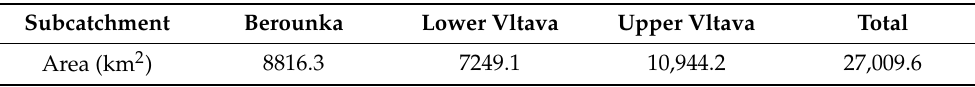
Figure 1. The Vltava River watershed with the pilot Blanice river catchment. Table 1. Area of the main individual